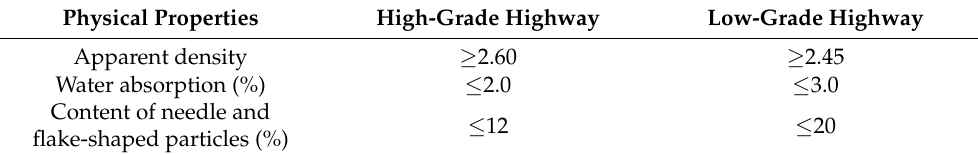
Table 2. Local standards of physical properties.